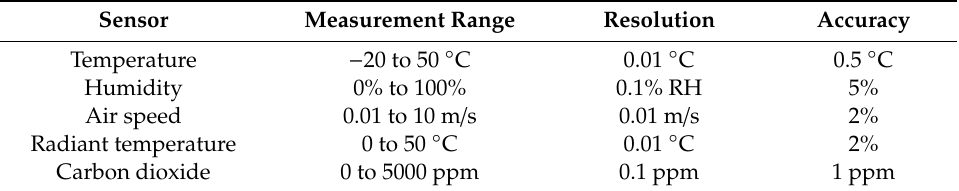
Table 3. Sensors Table 3. Sensors information.